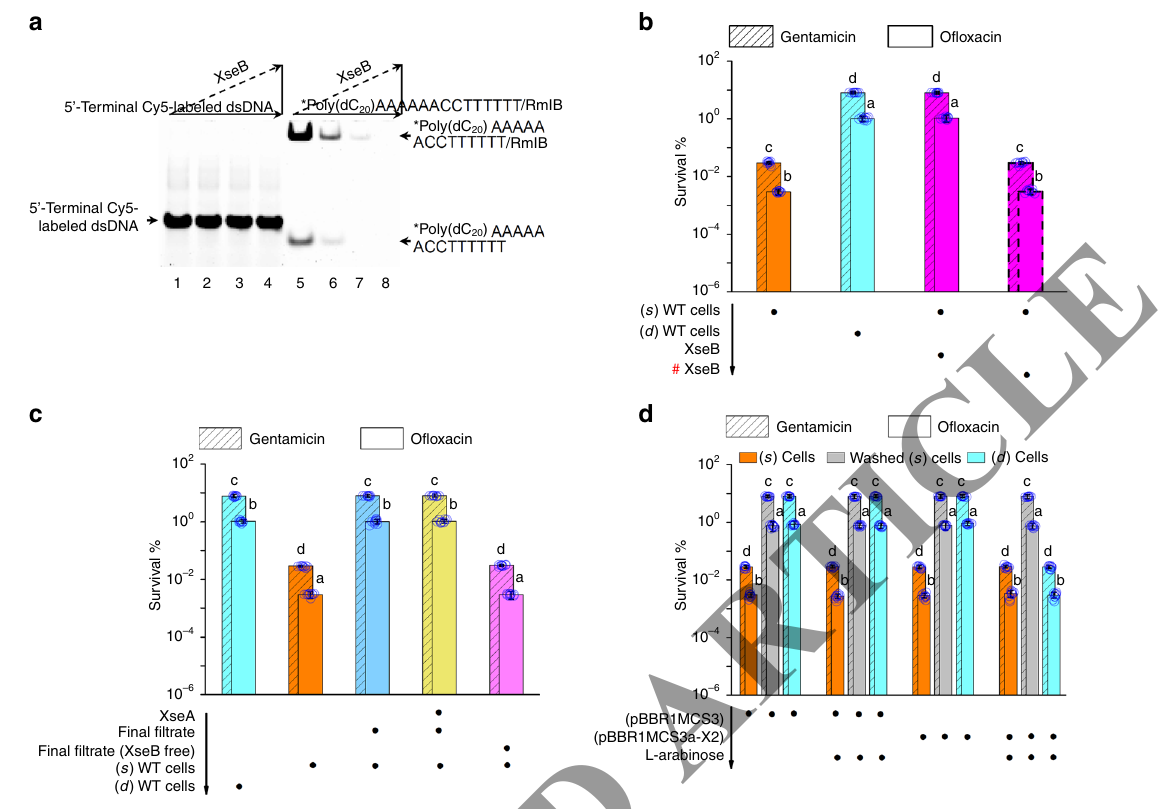
Fig. 3 Extracellular XseB in-situ tailors poly(dC) at 5 ′ terminus. a Assays for the single strand-speci fi c 5 ′ → 3 ′ cleavage activity of XseB. A Cy5 fl uorescent label was attached to 5 ′ terminus of ssDNA with a hairpin structure in its 3 ′ terminus (5 ′ -*poly(dC 20 )AAAAAACCTTTTTT-3 ′ ) or was attached to 5 ′ terminus of dsDNA (5 ′ -*GTCATTCTGAGAATAGTGTAG-3 ′ ). The recombinant XseB resulted in the disappearance of fl uorescence in free and RmlB-bound ssDNA rather than dsDNA. b Persistence in ( s ) WT cells plus recombinant XseB. The XseB-treated ( s ) WT cells exhibited the same persister level as that in ( d ) WT cells. c Persistence in ( s ) WT cells that was resuspended in the fi nal fi ltrate plus His-tagged XseA or in the XseB-free fi nal fi ltrate. Both the fi nal fi ltrate and the His-tagged XseA treated fi nal fi ltrate increased persistence in ( s ) WT cells. But the XseB-free fi nal fi ltrate failed to increase persistence in ( s ) WT cells. d Persistence in cells expressing xseB asRNA . Plasmid pBBR1MCS3a-X2 had a xseB asRNA expression cassette. Expression of xseB asRNA with 0.2% L -arabinose induction caused the loss of persistence enhancement in the ( d ) cells. As a control, the stimulation in persistence was still present in the ( d ) cells harboring pBBR1MCS3a-X2 without L -arabinose induction. Washing increased persistence in the ( s ) cells harboring pBBR1MCS3a-X2 no matter with or without L -arabinose induction. All experiments were performed in biological triplicates. Error bars represent standard deviations. Dot plots overlaid on bar graphs represent individual data points. Black spot, treatment step or object; arrow, treatment order; hash sign, inactivated